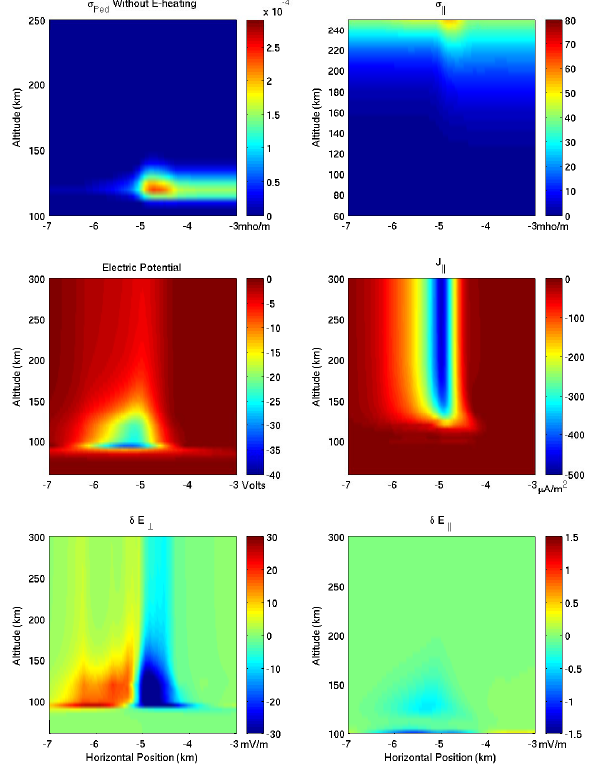
Fig. 3. TRANSCAR output in the absence of E -region electron heating by plasma waves and with the precipitation flux given in Fig. 1.